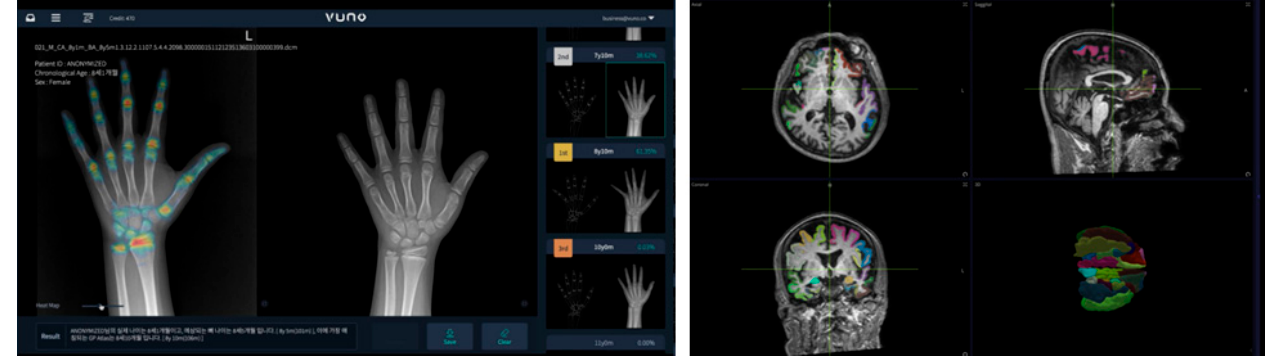
Figure 1. The image of VUNO’s artificial intelligence diagnosis program.